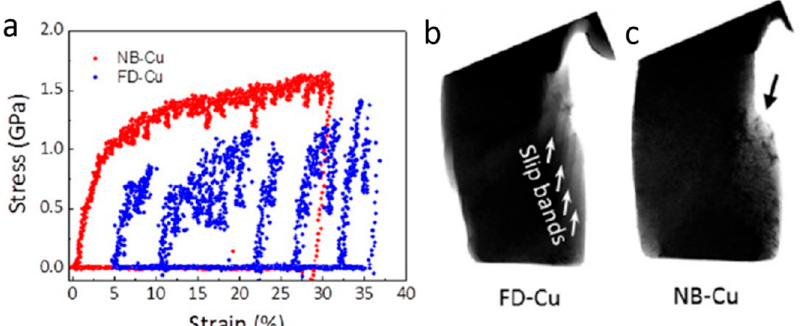
Figure 16. Compression tests on FD-Cu (unirradiated) and NB-Cu (irradiated) pillars: ( a ) NB-Cu containing nanoscale He bubbles deliver stable deformability and higher flow strength; ( b ) sharp slip bands are identified in FD-Cu pillar; and ( c ) smooth deformation profile is identified in NB-Cu pillar. Reprinted with permission from [122]; Copyright 2016 American Chemical Society.